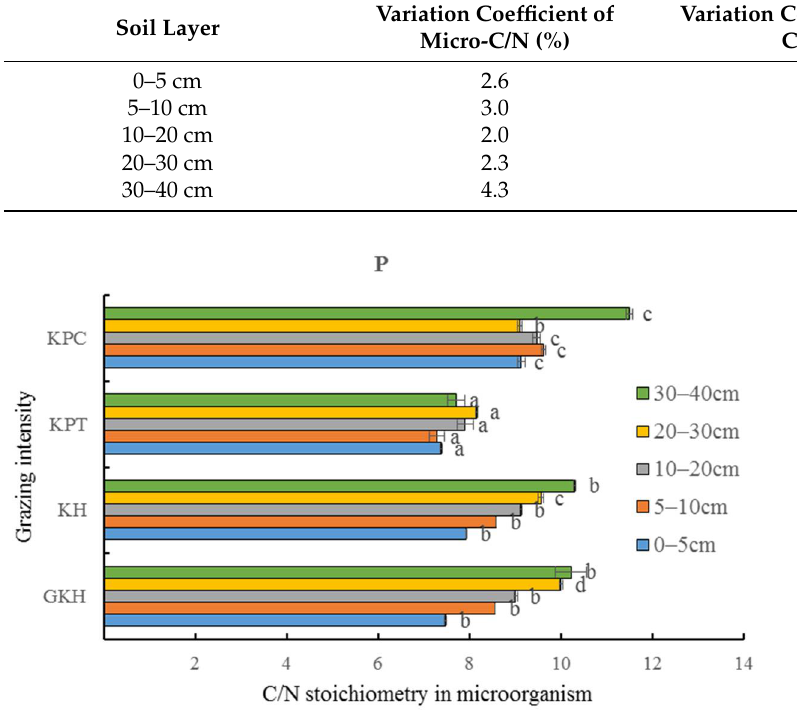
Figure 12. C/N (total carbon/ total nitrogen) stoichiometry in microorganisms at different grazing intensities: GKH (3.75 ± 0.75 sheep/ha), KH (7.25 ± 0.25 sheep/ha), KPT (8.50 ± 0.35 sheep/ha), and KPC (11.75 ± 0.95 sheep/ha). Notations: different letters indicate significant differences between pastures ( α =